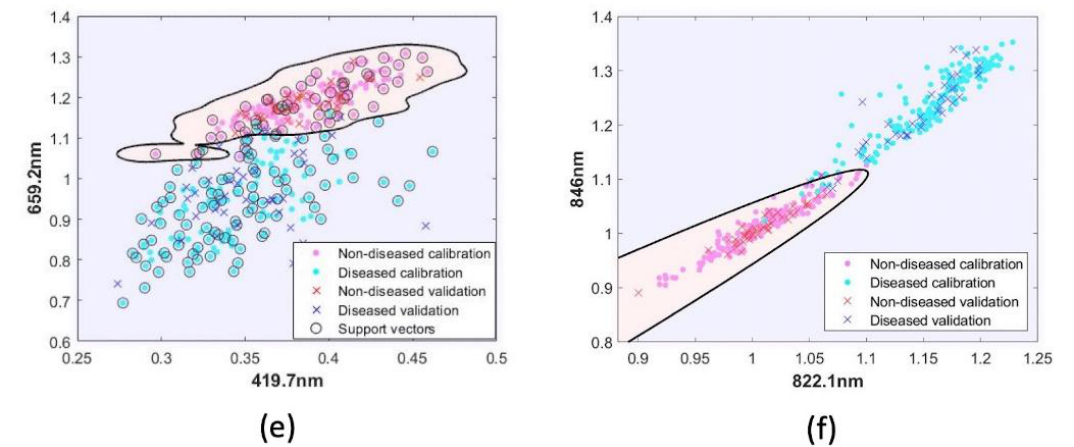
Figure 5. The decision boundaries are visualized by using two wavelengths. ( a , b ) show LDA with range normalization and QDA with range normalization. ( c , d ) show SVM with raw data and RBF SVM with raw data. ( e , f ) show RBF SVM with range normalization and QDA with SNV.